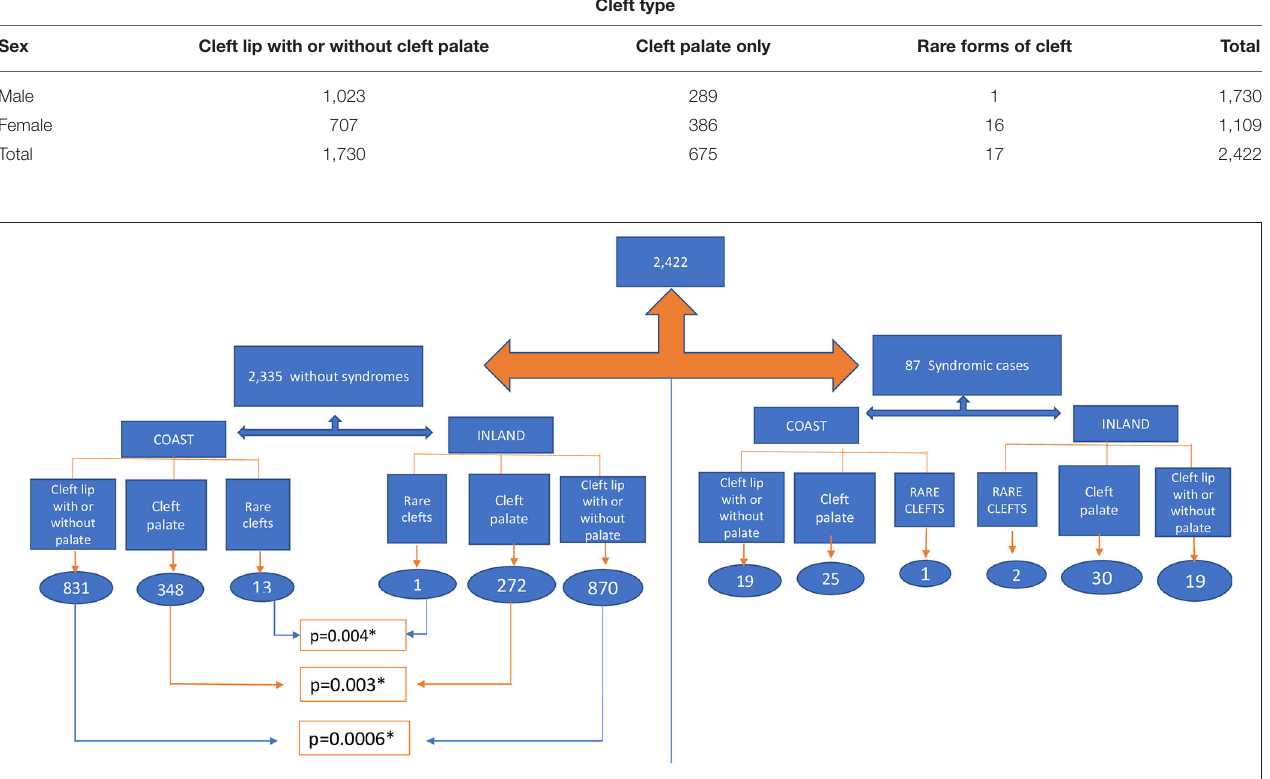
FIGURE 1 | Distribution of orofacial clefts according to type and geogaphic origin. *indicate statistically significant